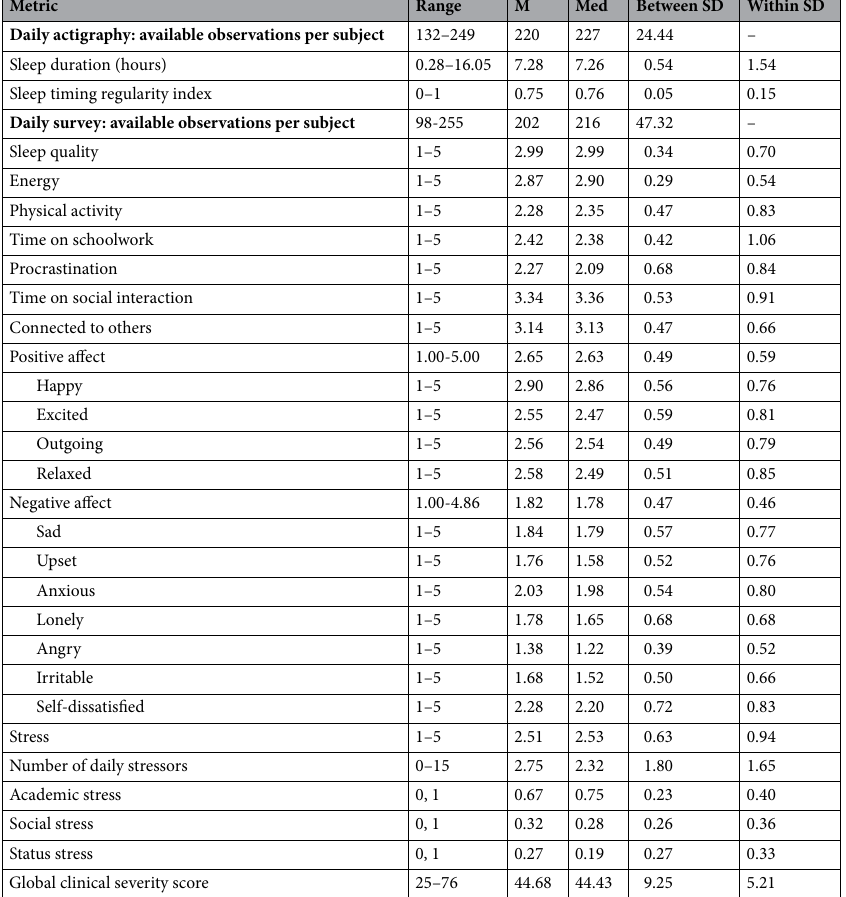
Table 1. Sample descriptive statistics. Range range of scores observed in the study, M between-subjects mean, Med between-subjects median, Between SD between-subjects standard deviation, Within SD mean of within- subject standard deviation. Positive affect and Negative affect are composite scores of the indented items listed below them (see